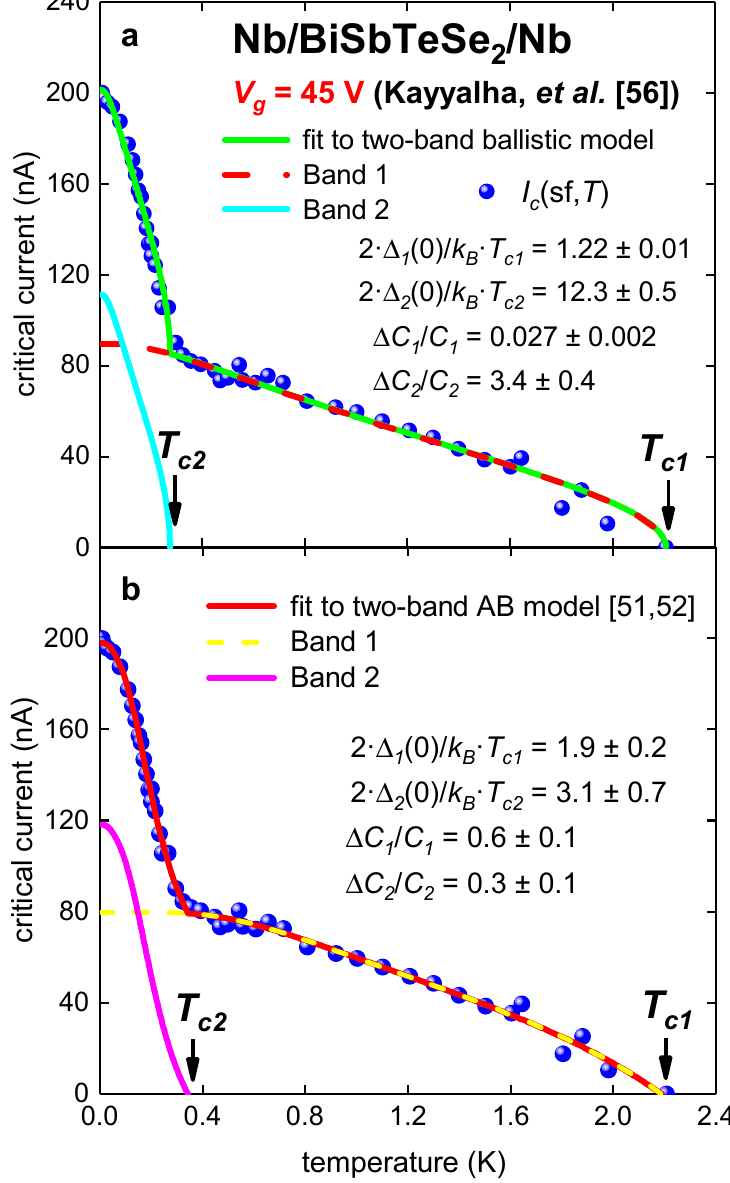
Figure 5. Experimental I c ( sf, T ) for Nb/BiSbTeSe 2 -nanoribbon/Nb junction (Sample 1 [56]) at gate Figure 5. Experimental I c (sf, T ) for Nb / BiSbTeSe 2 -nanoribbon / Nb junction (Sample 1 [56]) at gate voltage V g = 45 V. ( a ) Ballistic model, fit quality is R = 0.994; ( b ) modified AB model [51,52]. Derived voltage V g = 45 V. ( a ) Ballistic model, fit quality is R = 0.994; ( b ) modified AB model [51,52]. Derived parameters: R n1 = 3.5 ± 0.3 k Ω , R n2 = 630 ± 110 Ω , fit quality is R = Table 5. Deduced parameters for for Nb/BiSbTeSe 2 -nanoribbon/Nb junction (Sample 1 [56]) at V g = 45 V from fit to two-band Titov and Beenakker (TB) [53] and Ambegaokar and Baratoff (AB) [7,8] models.